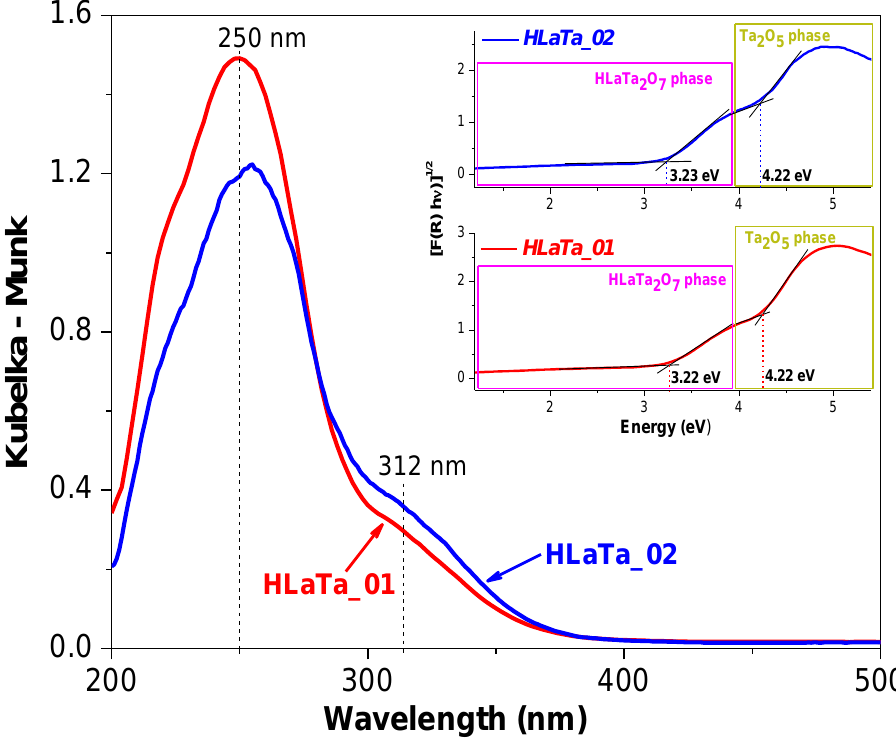
Figure 7. UV-Vis spectra of HLaTa_01(02) protonated products and their corresponding band gap energy values.